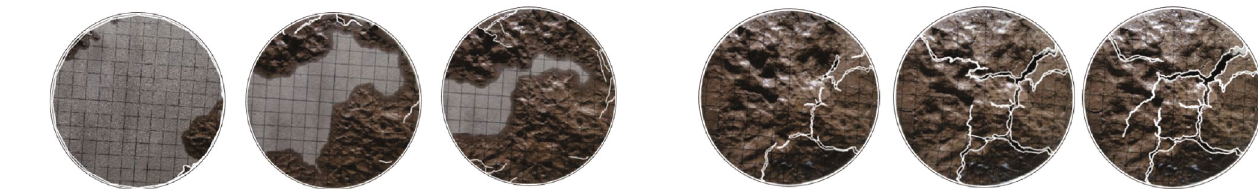
Figure 7: Generation stage.